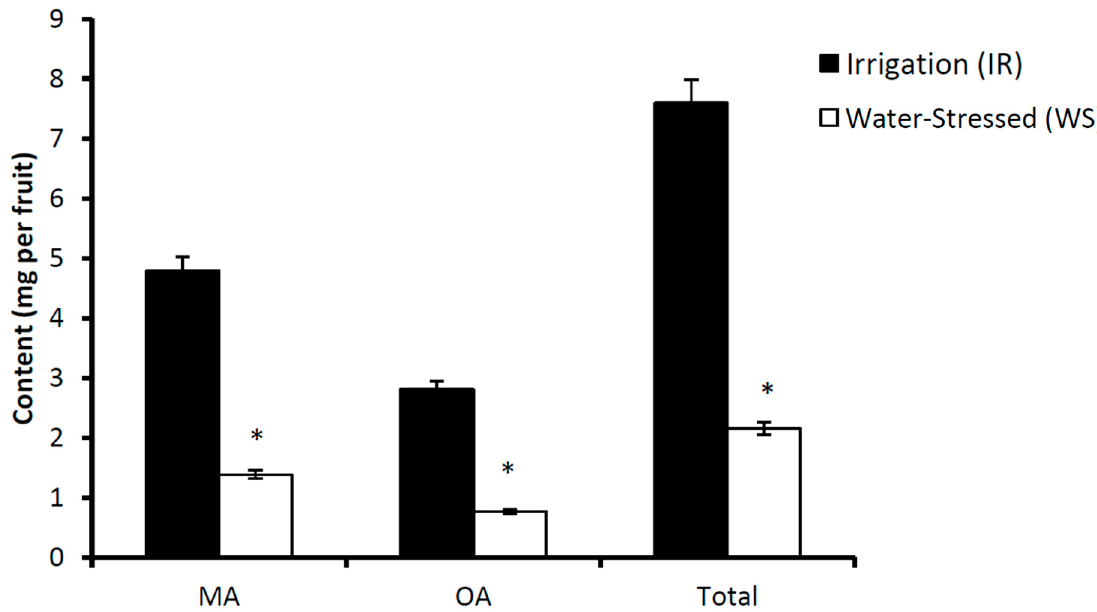
Figure 6. Content of triterpenes (mg) of irrigated (IR) or water-stressed (WS) fruits of cv. Picual olive trees. The content of each triterpene was calculated by multiplying the concentration, expressed as mg per g of fresh weight, by the fruit pulp weight. MA—maslinic acid, OA—oleanolic acid, Total: Sum of maslinic acid and oleanolic acid. For comparisons between the irrigation and water stress conditions, * p < 0.05.